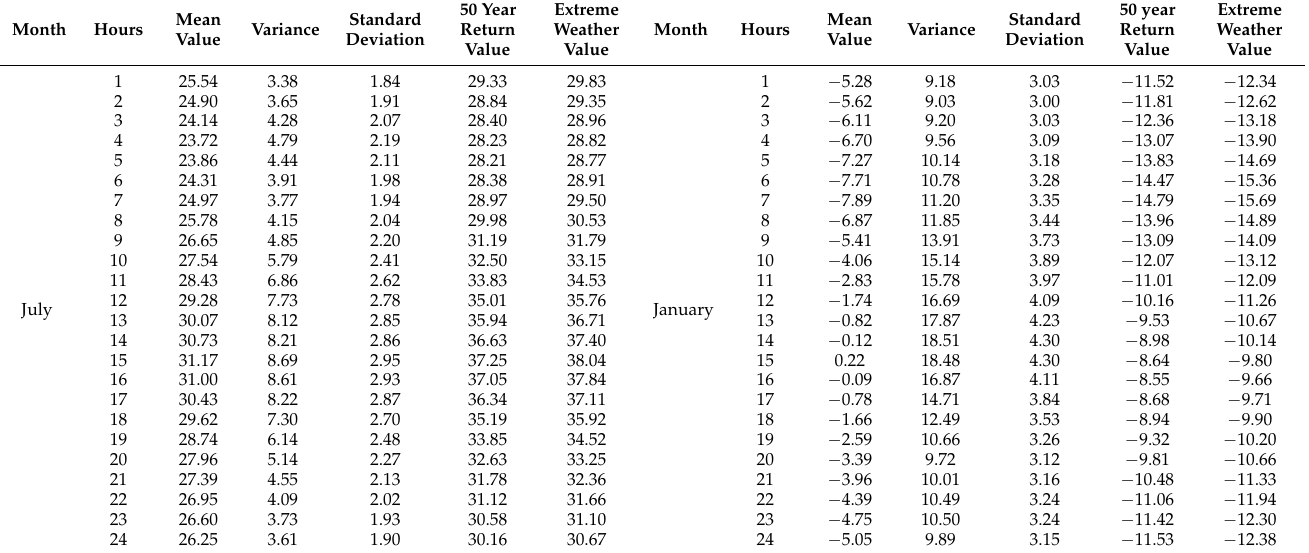
Table 1. Temperature in July and January in Beijing ( ◦